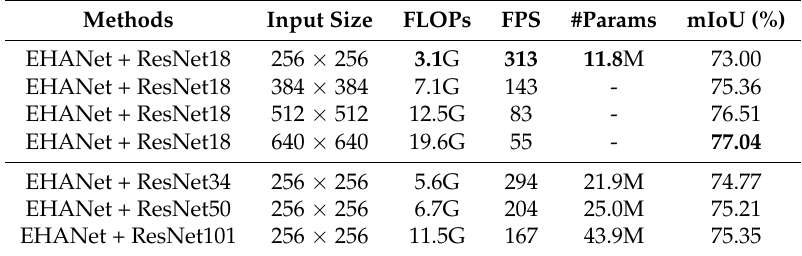
Table 5. Performance comparison of models at different resolutions and different backbones. M = 10 6 , G = 10 9 . “-” represents the same statistics as